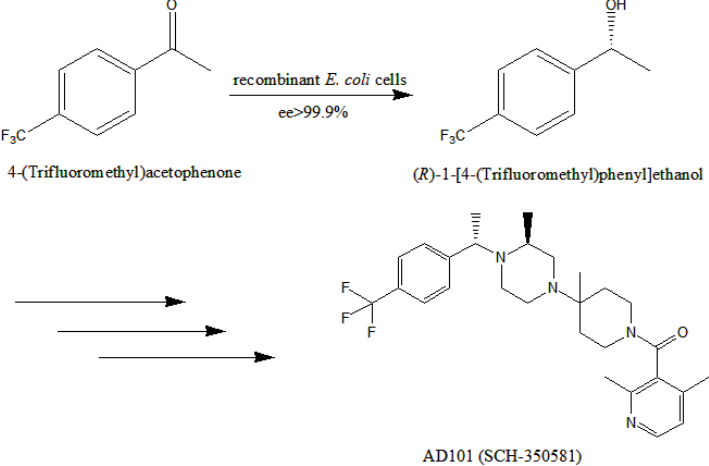
Figure 1. The biological asymmetric reduction route.